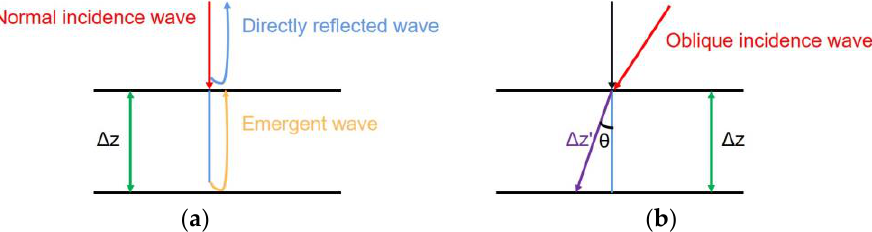
Figure 4. Cross-polarization reflection coefficient amplitudes for various incidence angles.